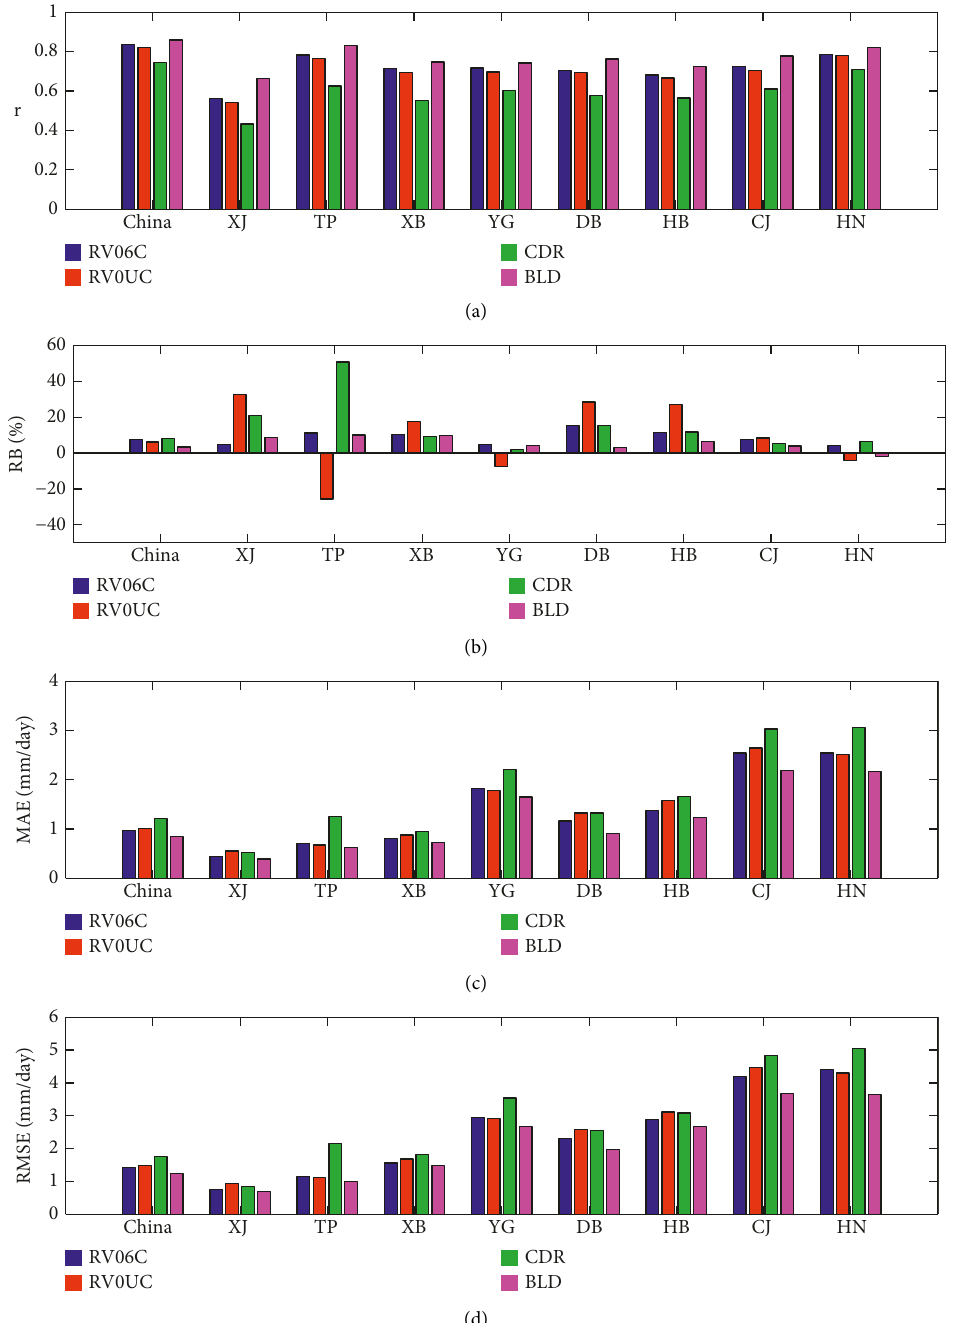
Figure 4: Values of r , RB, MAE, and RMSE performance metrics for mean areal precipitation estimate time series derived from RV06C, RV06UC, CDR, and BLD during the period from March 2014 to June 2018 over Mainland China and the eight